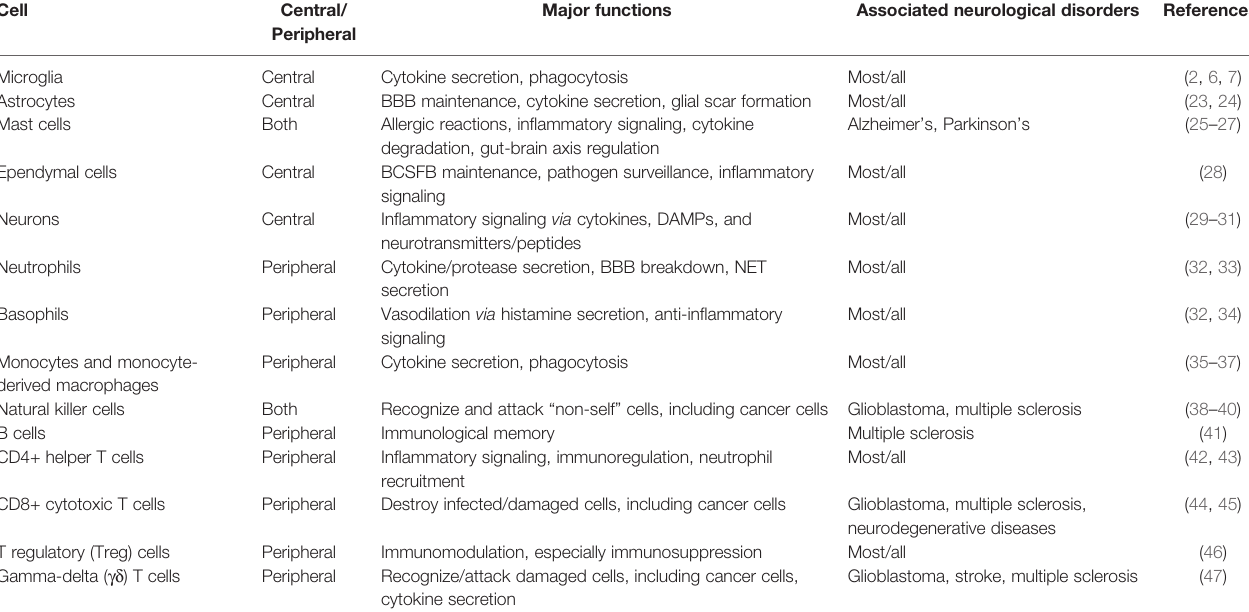
TABLE 1 | Major immune effector cells in neurological disorders.